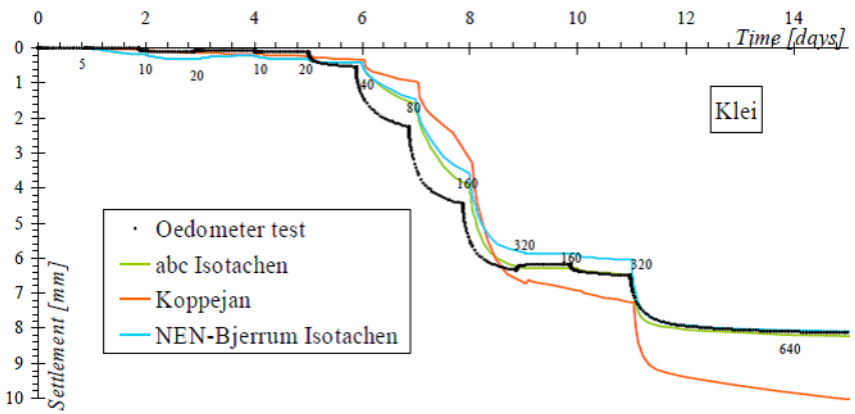
Figure 6. The performance of a series of models used to calculate settlement compared to Oedometer test results. Prediction made by classic models such as Koppejan fit the measurements less well compared to models based on the isotachs method, such as NEN-Bjerrum or